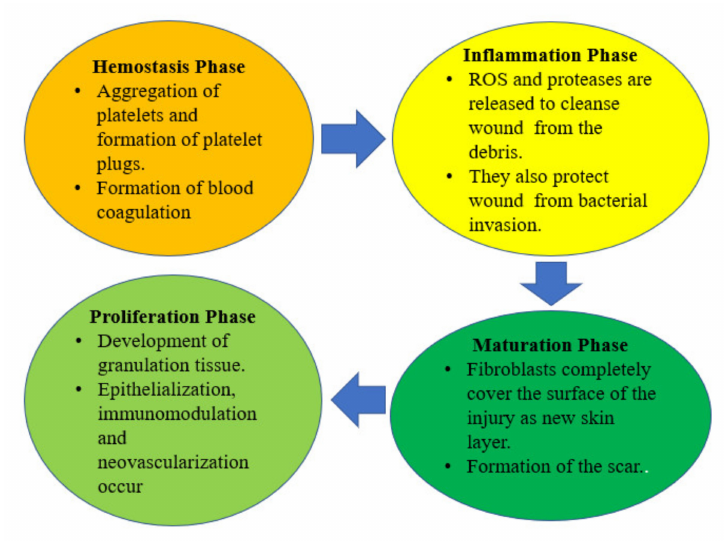
Figure 2. Consecutive phases of the wound healing